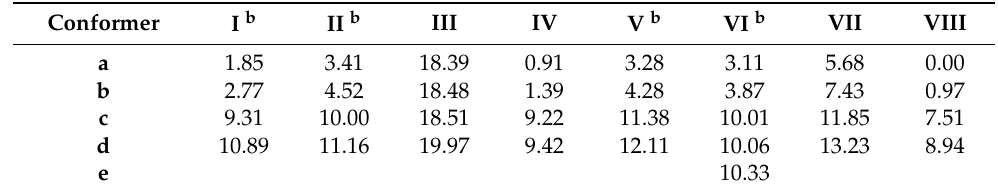
Table 2. Relative free energies ( ∆ G, kcal/mol, 1 atm, 25 ◦ C) a obtained for the 4–5 most stable conformers of lithium alkoxides I–VIII .